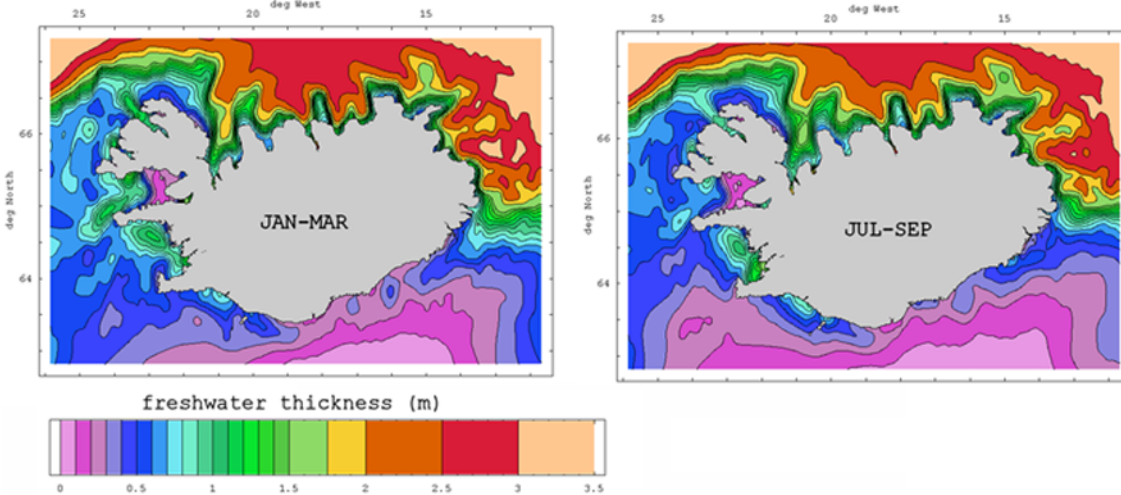
Fig. 8. Mean simulated winter (left) and summer (right) freshwater thickness of Icelandic waters for the time period 1992 to 2006.